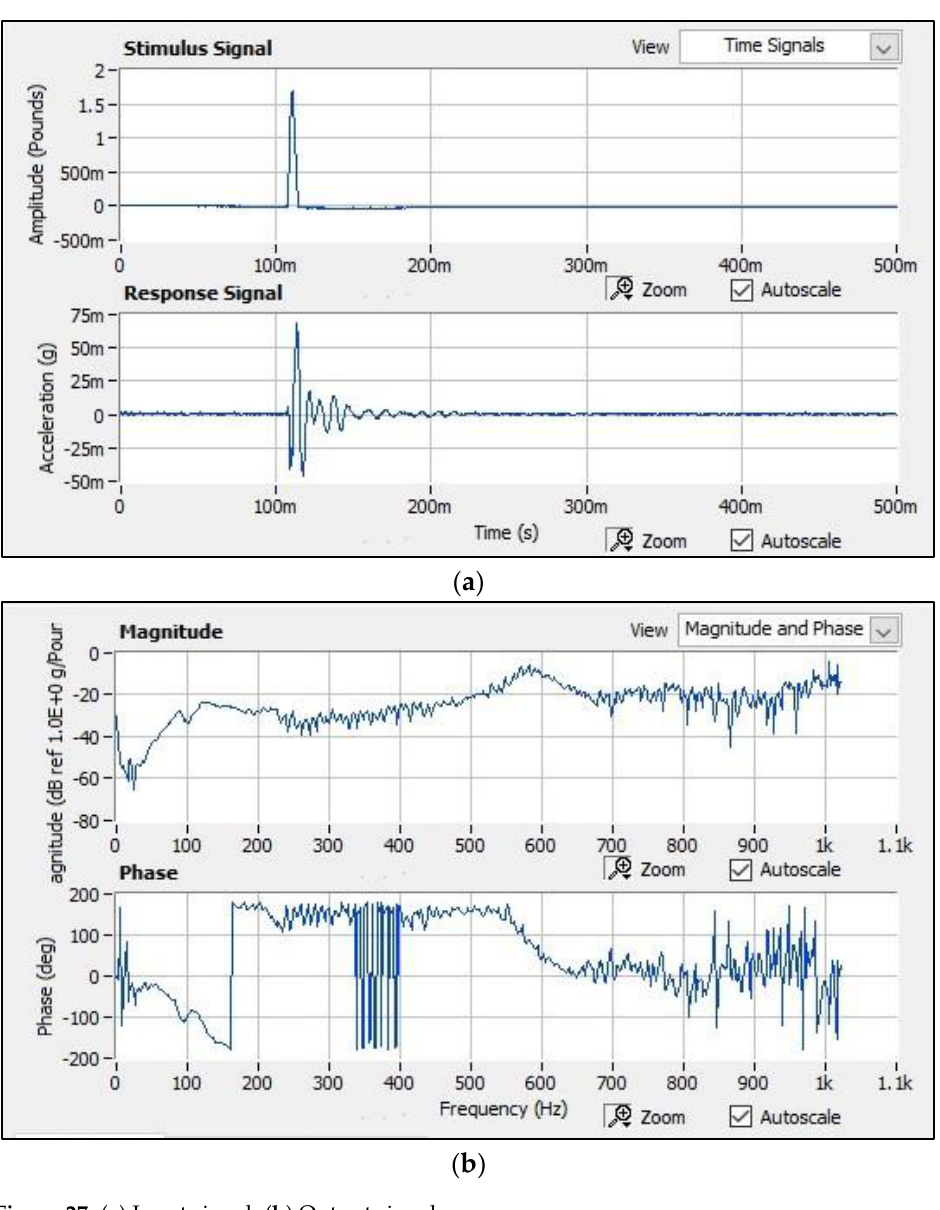
Figure 27. ( a ) Input signal. ( b ) Output signal.